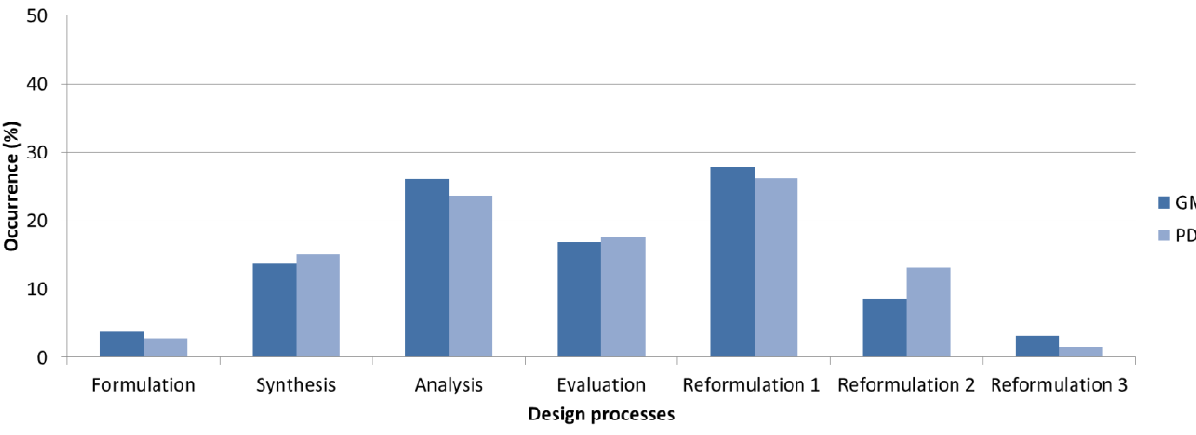
Figure 4. Design process distribution in GME vs.